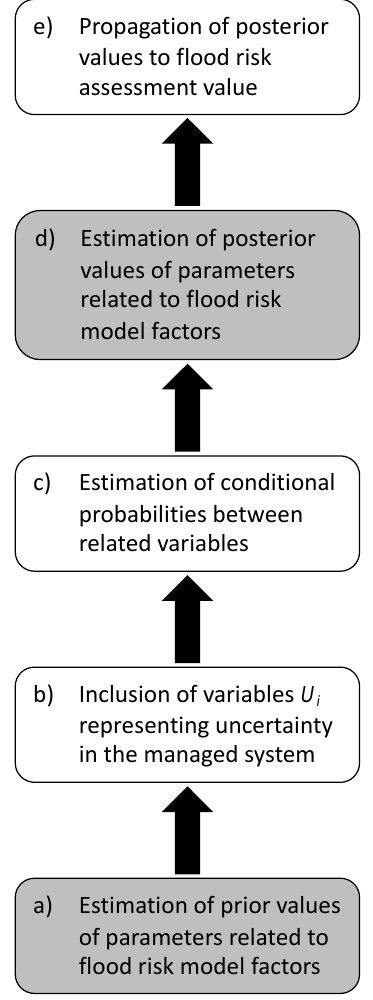
Figure 7. A flowchart for development of the Bayesian network model.